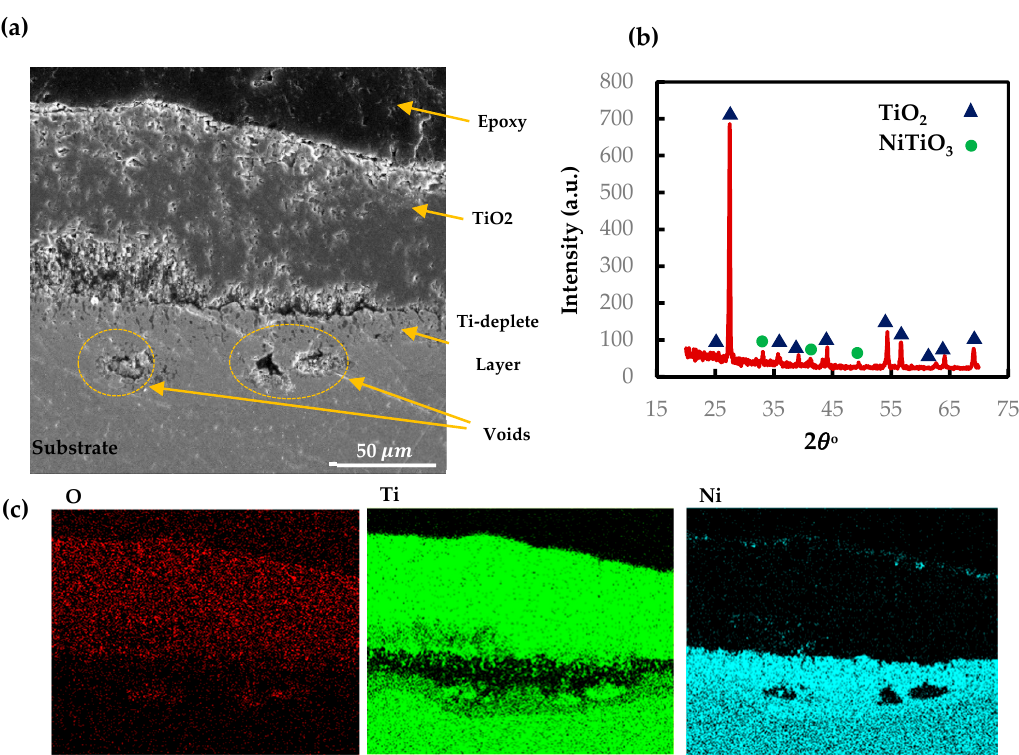
Figure 9. ( a ) SEM micrographs of cross sections of AM NiTi alloy at 900 °C, ( b ) XRD patterns performed on the surface of the oxidized AM NiTi at 900 °C, ( c ) X-ray mapping of the cross section of the oxide layer of AM NiTi.